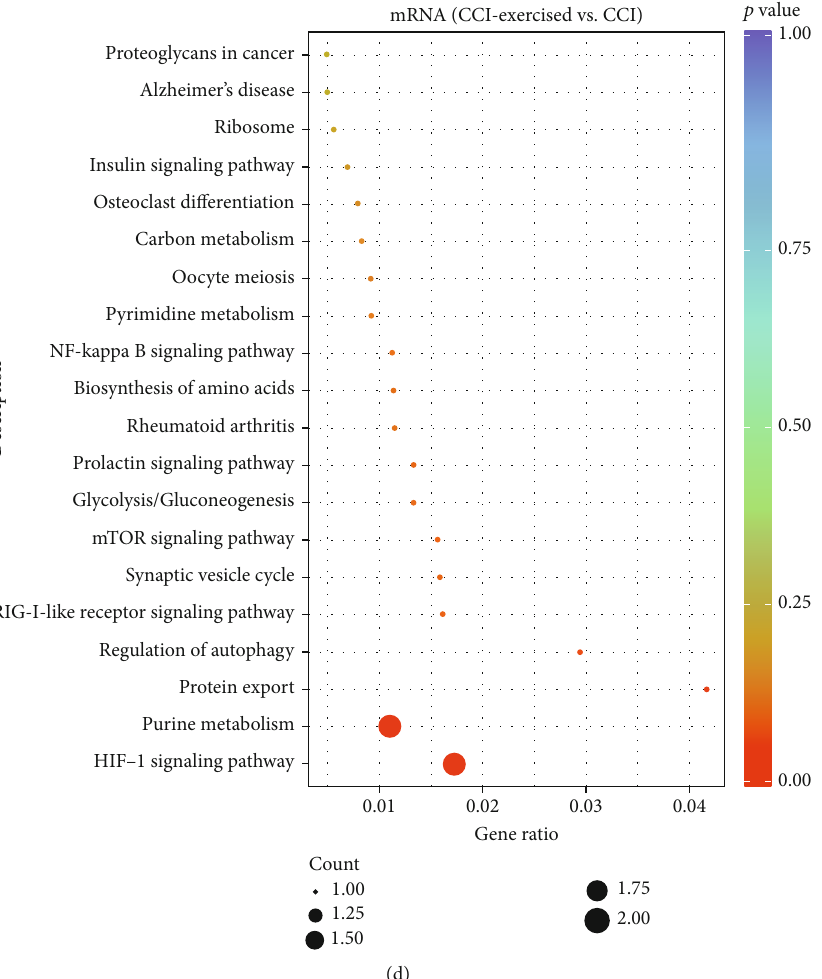
Figure 8: Kyoto Encyclopedia of Genes and Genomes (KEGG) pathway scatterplots of di ff erentially expressed genes (DRGs). MicroRNA- (miRNA-) enriched KEGG pathway scatterplots showing statistics of pathway enrichment in comparisons of (a) the sham-operated group versus the chronic constrictive injury (CCI) group and (b) the CCI-exercised group versus the CCI group. mRNA-enriched KEGG pathway scatterplots showing statistics of pathway enrichment in comparisons of (c) the sham-operated group versus the CCI group and (d) the CCI-exercised group versus the CCI group. The size of the point represents the number of candidate target genes in the pathway, and the color of the point corresponds to di ff erent p value ranges ( n = 3 animals per